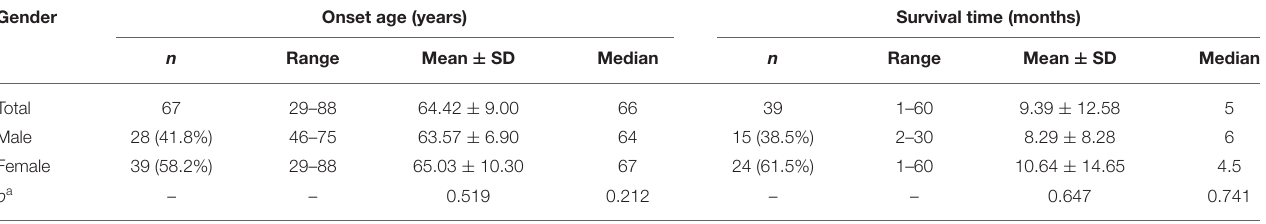
TABLE 1 | Onset age and survival time of sporadic Creutzfeldt–Jakob disease (sCJD). Gender Onset age (years) Survival time (months) n Range Mean ± SD Median n